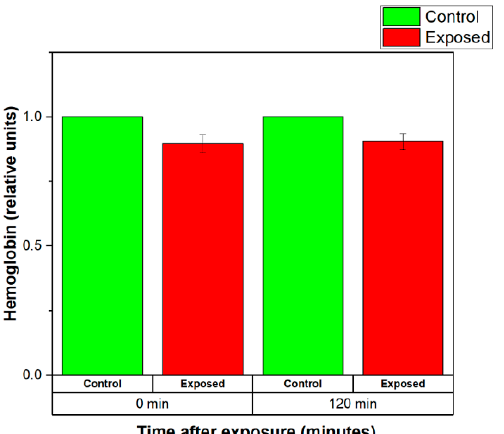
Figure 10. Normalized levels of the hemoglobin released by the control (sham-exposed) and ex- posed erythrocyte suspensions for 20 min to 2.41 GHz (WSA SAR = 0.4149 W/kg, psSAR1g = 0.5758 W/kg, wearable antenna input power 6.3 mW, Zigbee-like signal). The mean of 10 experiments ± SEM is shown.